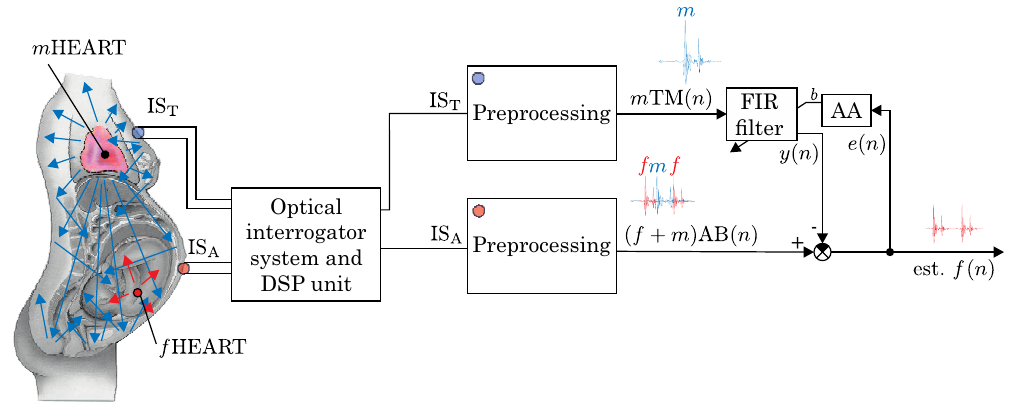
Figure 3. Basic schematic diagram for our noninvasive PPG-based interferometric sensors and adaptive system for fHR